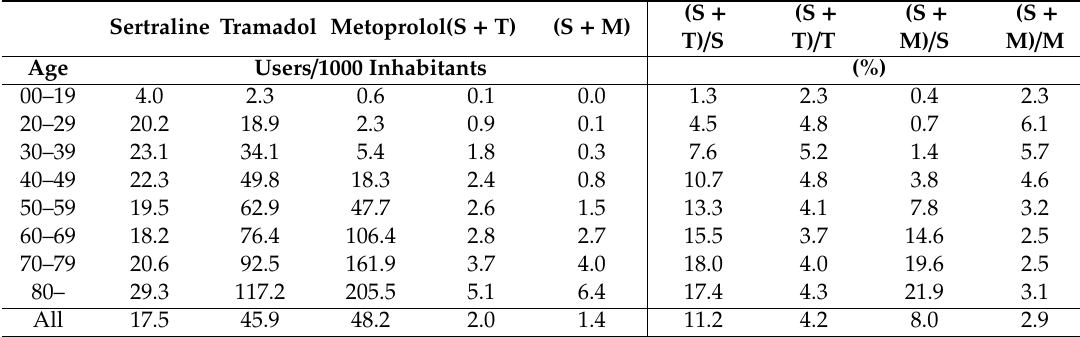
Table 5. Age distribution of consumption in terms of